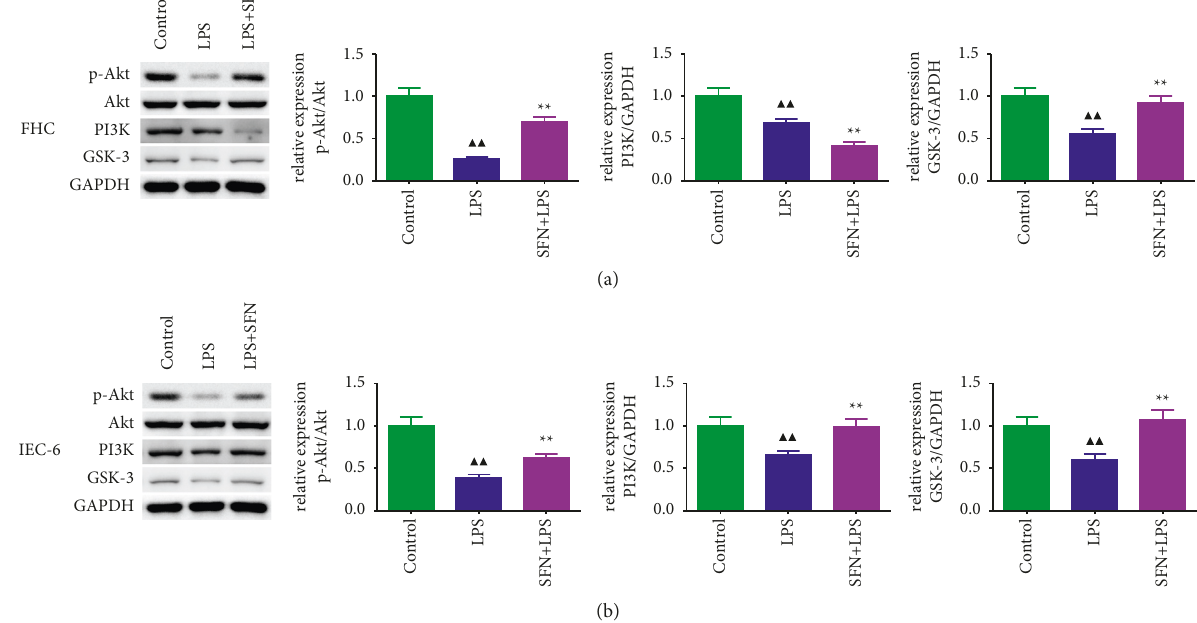
Figure 8: Expression of PI3K/Akt/GSK-3 β pathway-related proteins in FHC (a) and IEC-6 (b) cells. LPS, lipopolysaccharide; SFN, sulforaphane. Compared with the control group, ▲ P < 0 . 05, ▲▲ P < 0 . 01; compared with the NEC group, ★ P < 0 . 05, ★★ P < 0 . 01. Data represent the mean ± SD, n �